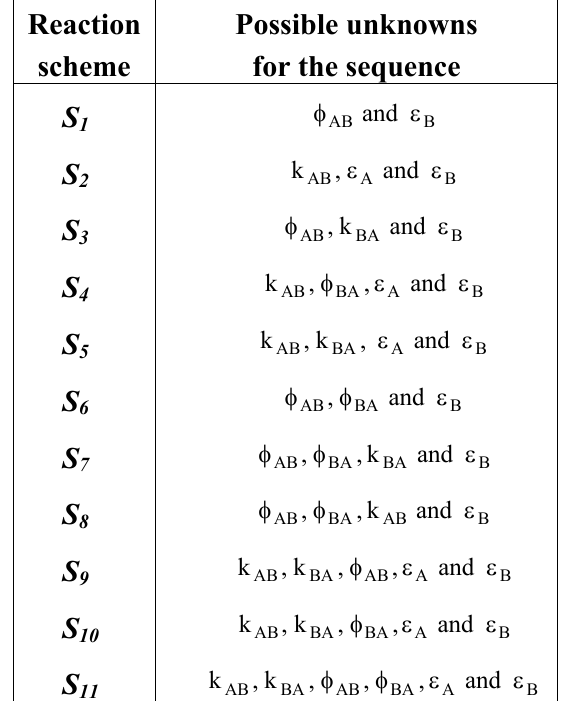
Table 2. Sets of unknowns specific to each kinetic case of Table